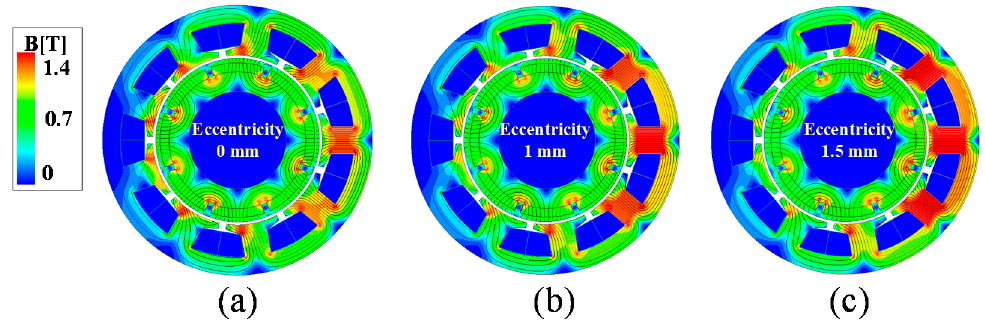
Figure 3. Magnetic flux density of analysis model: ( a ) ec = 0 mm, ( b ) ec = 1 mm, and ( c ) ec = 1.5 mm.